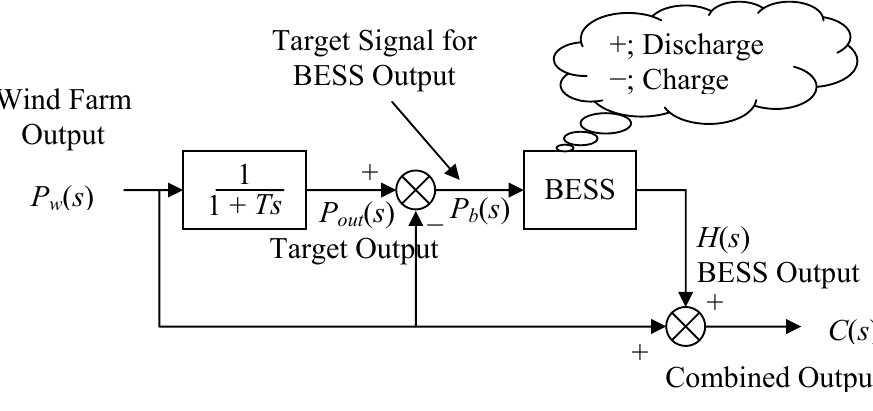
Figure 2. The simplified diagrams of power smoothing control